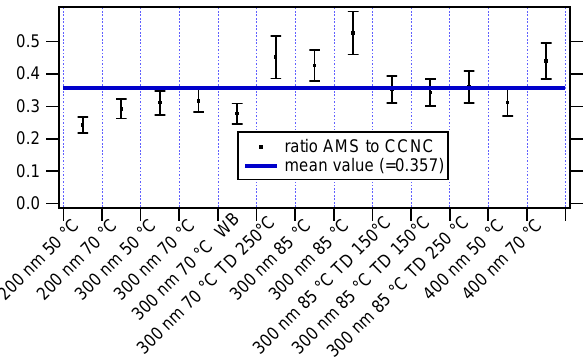
Fig. A1. Collection efficiency (CE) for all experiments using coated BCR particles. The labels of each data point refer to the treatments used in each experiment. The first number is the size of the particles. It is followed by the temperature of the sulphuric acid coating unit. WB indicates the use of the water bath and TD indicates that the thermodenuder was used at the temperature following “TD”.